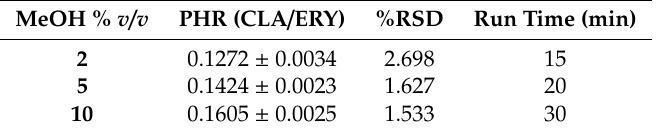
Table 4. Chromatographic response of CLA and ERY with changes in mobile phase content ( n = 3).